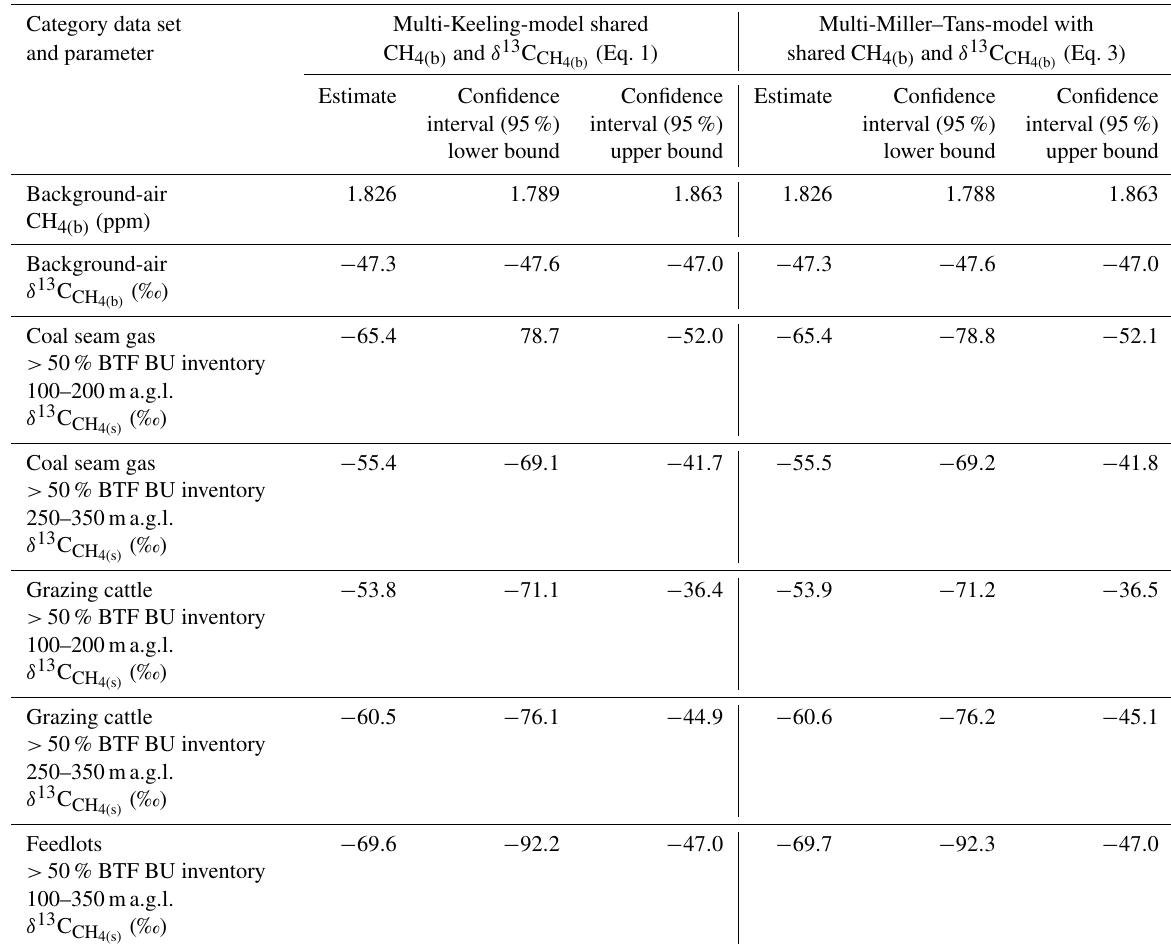
and using multi-Miller– 4(b) (Eq. 3) 4(b)